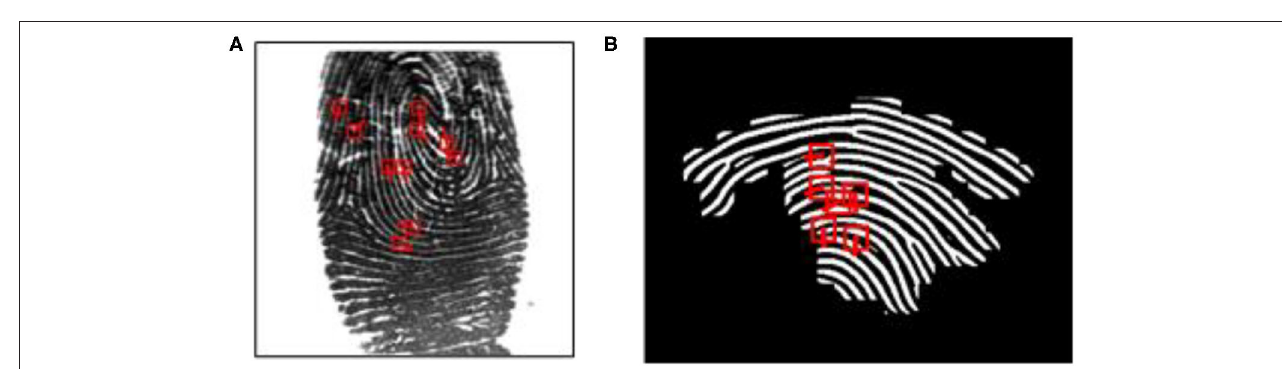
FIGURE 12 | An unidentified latent fingerprint of NIST SD27 by CNNAI. (A) Original. (B) Enhanced.